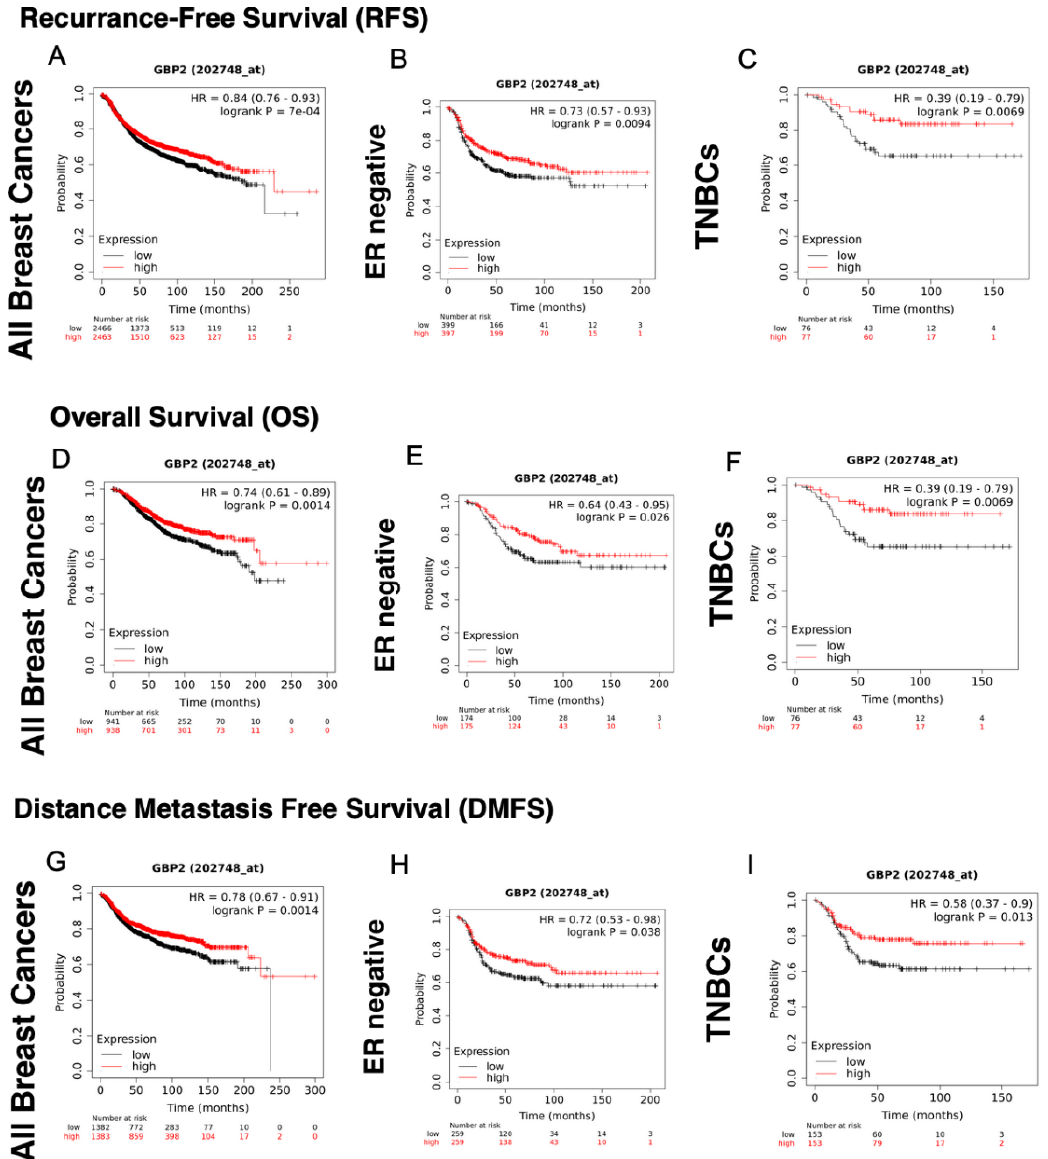
Figure 3. GBP-2 correlates with better recurrence-free (RFS), overall survival (OS), and Distance Metastasis-free Survival (DMFS) in a cohort containing all breast cancers. The probability of RFS versus time for breast cancers of all types, stages, and grades was plotted for those tumors with high and low levels of GBP-2 expression ( A ). The probability of RFS versus time was plotted for ER-, PR-, and HER2- (TNBC) breast cancers for high versus low levels of GBP-2 expression ( B , C ). The OS of patients of patients with all subtypes, stages, and grades was plotted for those tumors with high versus low GBP-2 expression versus time ( D ). The probability of OS versus time was plotted for ER-, PR-, and HER2- (TNBC) breast cancers for high versus low levels of GBP-2 expression ( E , F ). The DMFS of patients of patients with all subtypes, stages, and grades was plotted for those tumors with high versus low GBP-2 expression versus time ( G ). The probability of DMFS versus time was plotted for ER-, PR-, and HER2- (TNBC) breast cancers for high versus low levels of GBP-2 expression ( H , I ).